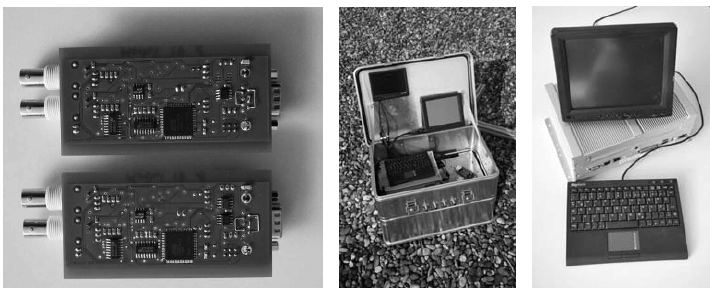
Fig. 8. Mechanical system for experimental investigations.